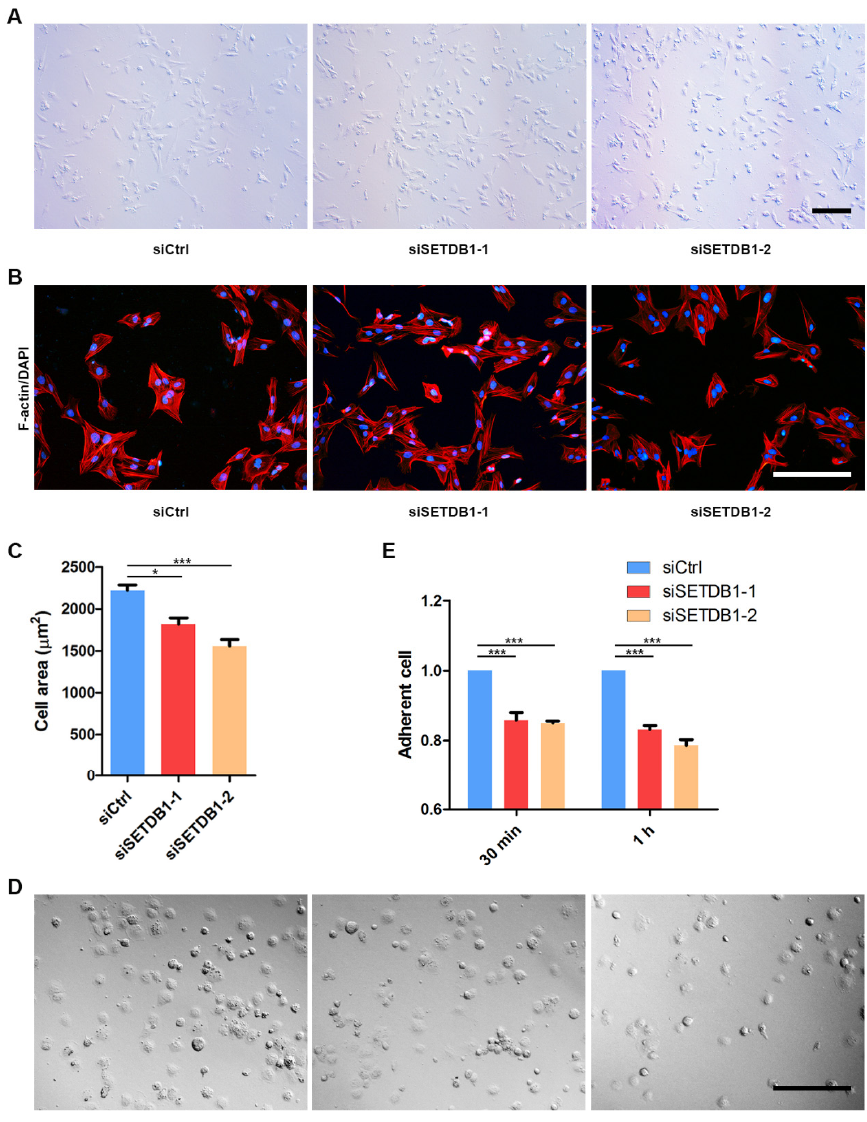
Figure 4. Knockdown of SETDB1 altered cell adhesion and cell spread. ( A ) Morphology of siSETDB1 and siCtrl cells. Scale bar = 100 µ m. ( B ) Detection of cell spreading area by F-actin (red) and DAPI (blue) staining. Scale bar = 100 μ m. ( C ) Analysis of cell area is shown in the column diagram. ( D ) Morphology of cells adhered for 30 min. Scale bar = 100 μ m. ( E ) Detection of adherent cells in each group by CCK-8 assay. Significance was presented as * p < 0.05, *** p < 0.001. Error bars represented the standard error of the mean (SEM).